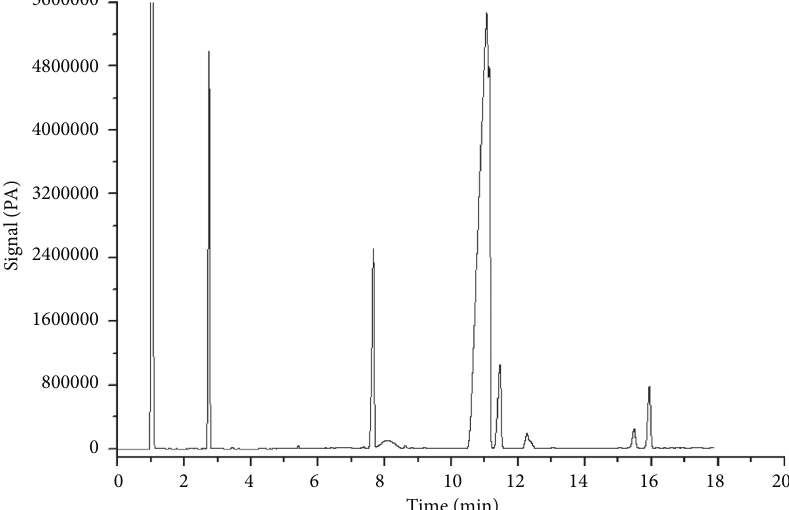
Figure 7: GC analysis of shea butter oil. 1. Octanoic acid, 2. Tridecenal, 3.2,4-Decadienal, 4.2,4-Decadienal, 5. Nonanoic acid, 6. Hex- adecanoic acid (palmitic acid), 7. Octadecanoic acid. (stearic acid), 8. Hexadecanoic acid (palmitic acid), 9.2,6,10,14,18,22-Tetracosa- hexaene, 10. Octadecenoic acid (oleic acid), 11. Octadecadienoic acid (linoleic acid).